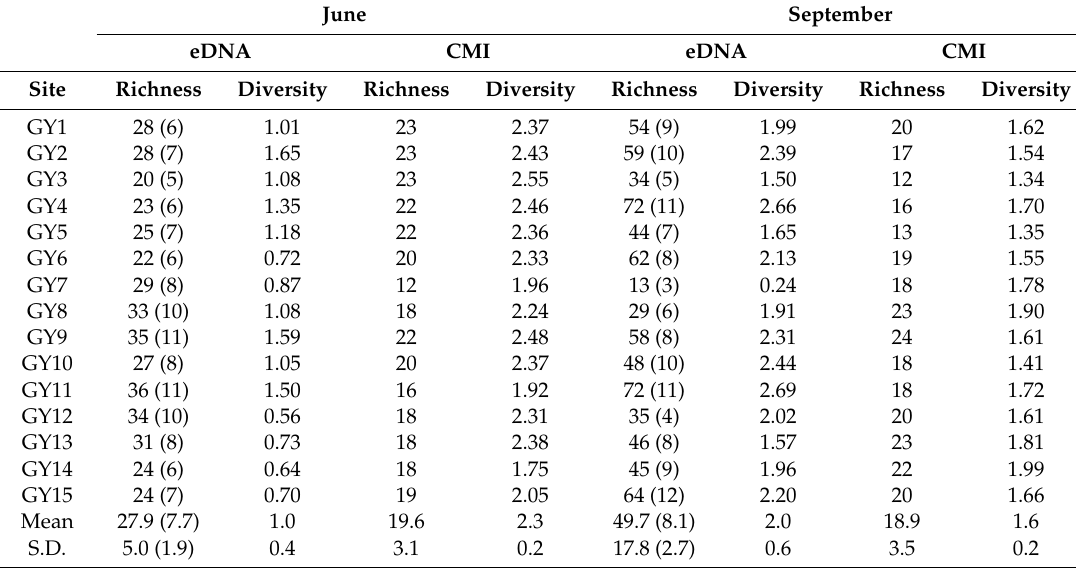
Table 1. Richness and Shannon diversity of the samples between water eDNA and conventional microscopic identification (CMI) in Gwangyang Bay. The numbers in the brackets indicate the number of unidentified groups. June